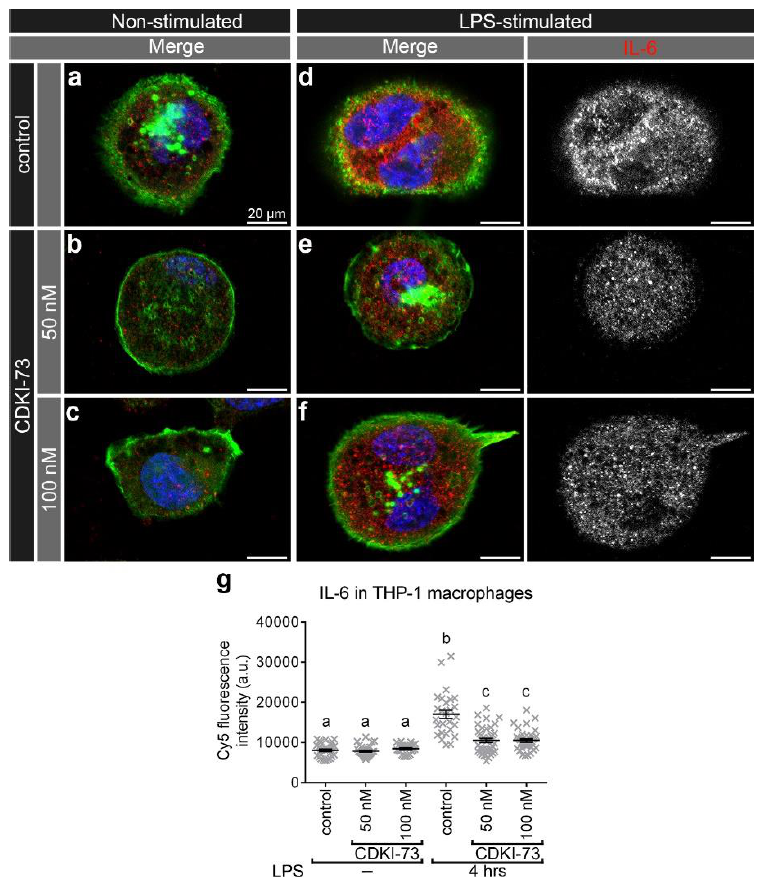
Figure 5. CDKI-73 depletes interleukin-6 (IL-6) in LPS-stimulated THP-1 macrophages. ( a – f ) Confocal micrographs showing IL-6 detected with anti-IL-6 antibody (red) in relation to the plasma membrane outlined with Alexa Fluor ® 488 Phalloidin (green). The nucleus was depicted by staining with Hoechst 33,258 DNA stain (blue). Representative images were from control THP-1 macrophages ( a , d ) and THP-1 macrophages treated either with CDKI-73 at 50 nM ( b , e ) or 100 nM ( c , f ) for four hours. The visualised macrophages were non-stimulated ( a – c ) and LPS-stimulated for six hours ( d – f ). Scale bars: 20 μm. ( g ) Histogram showing comparative analysis of IL-6-Cy5 signal in the designated samples. One-way ANOVA and Tukey’s multiple comparison test showed significant differences between the means in designated groups (depicted by different letters on the bars, p < 0.0001). Data are represented as mean ± SEM.